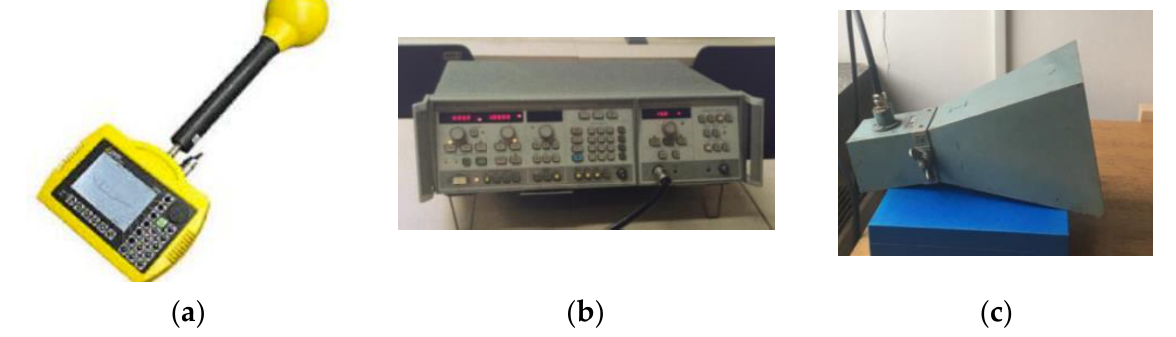
Figure 3. Measuring set-up: ( a ) measuring instrument NARDA SRM 3000; ( b ) HP 8350 B signal generator; ( c ) horn antenna .